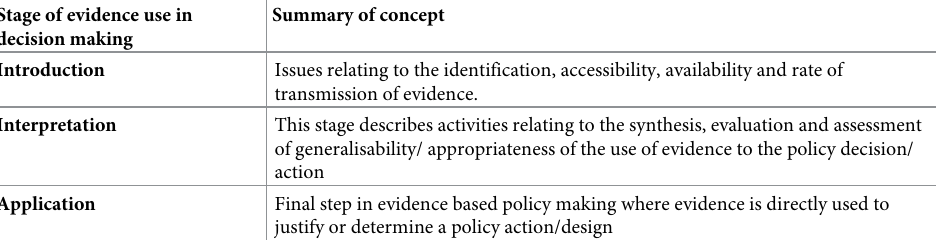
Table 3. Summary of the three stages of evidence use as outlined by conceptual framework for context-based evi- dence-based-policy decision making (Dobrow et al., 2004). Stage of evidence use in decision